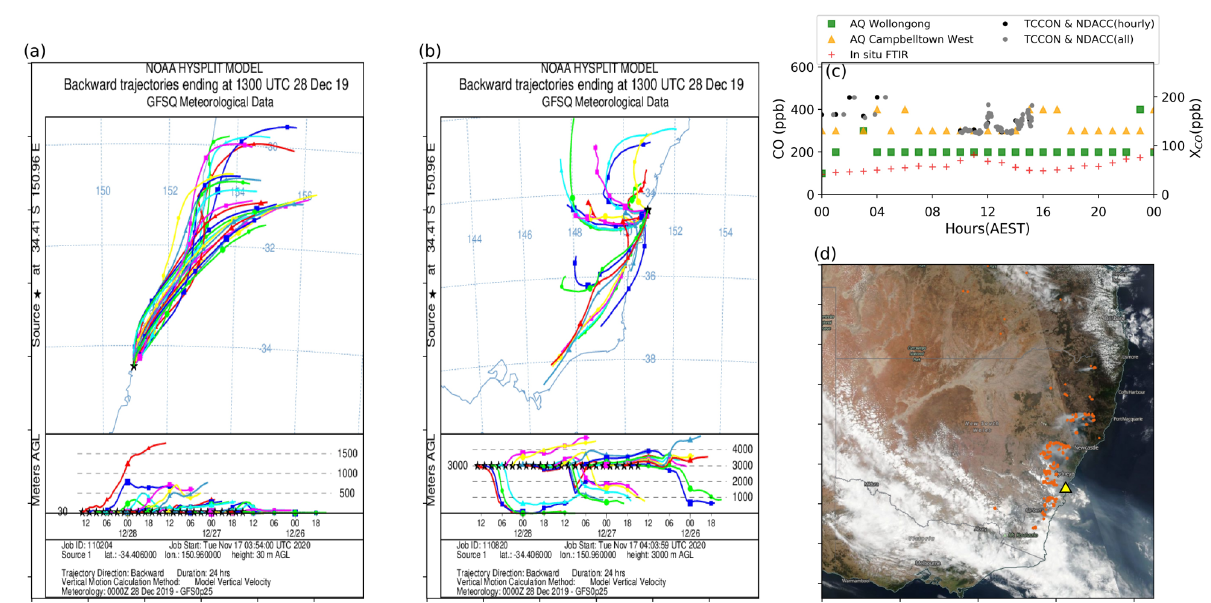
Figure A1. As for Figure 8, but for 28 December 2019.